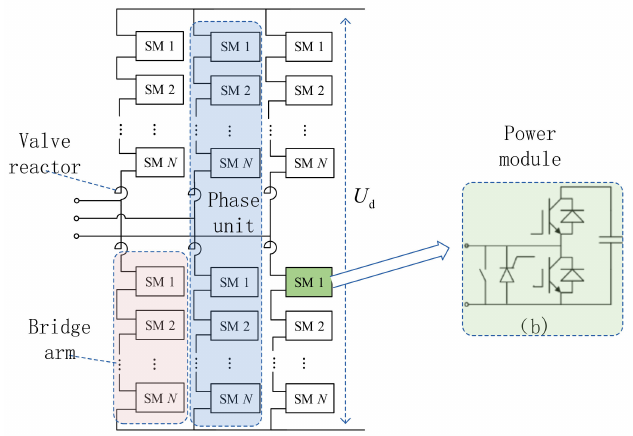
Figure 2. Converter Topology of Tangjia Station and Jishan II